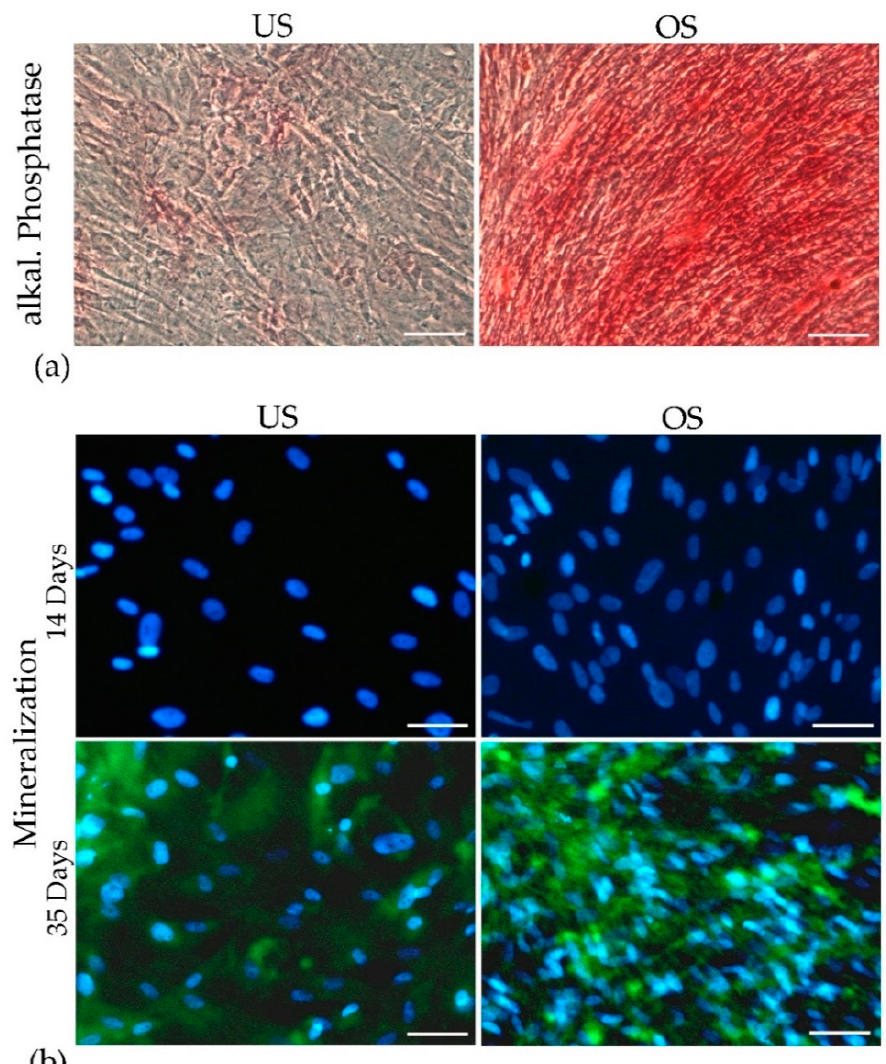
Figure 5. Osteogenic differentiation of adMSC in 2D culture. ( a ) Alkaline phosphatase staining in unstimulated cultures (US) and after osteogenic stimulation (OS) after 21 days. ( b ) Staining of mineralization by OsteoImage TM after 14 and 35 days in US cultures and in OS cultures (Observer Z1, Zeiss, scale bar: 100 µm).